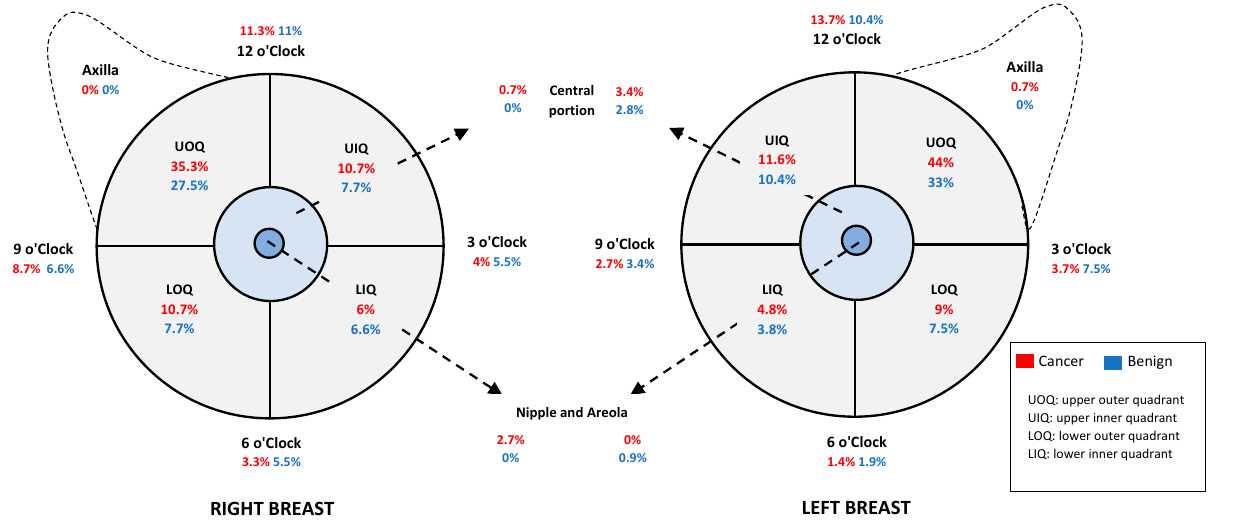
Figure 1. The distribution of breast lesion locations in the right and left breast.